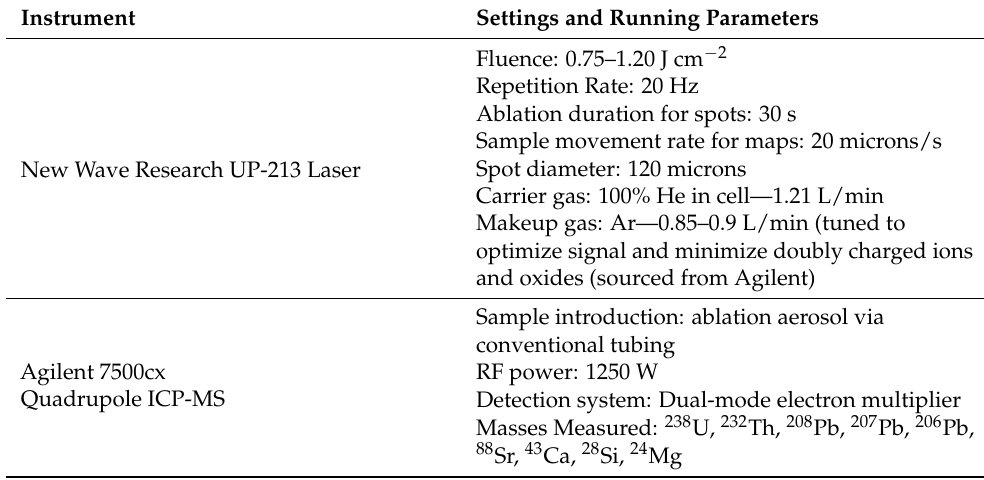
Table 1. Laser ablation instruments and parameters used in this study (Stony Brook University).